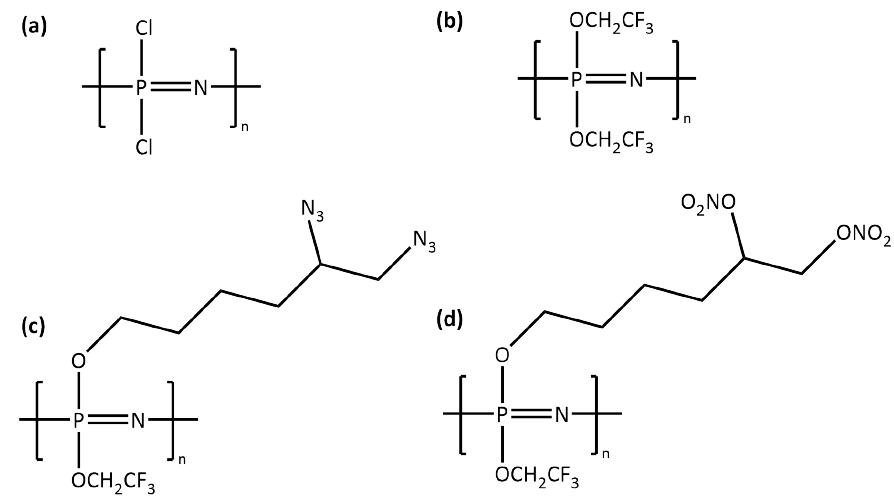
Figure 1. Molecular structures of repeat units: ( a ) PZ-DC, ( b ) PZ-TFE, ( c ) PZ-Azido and ( d )